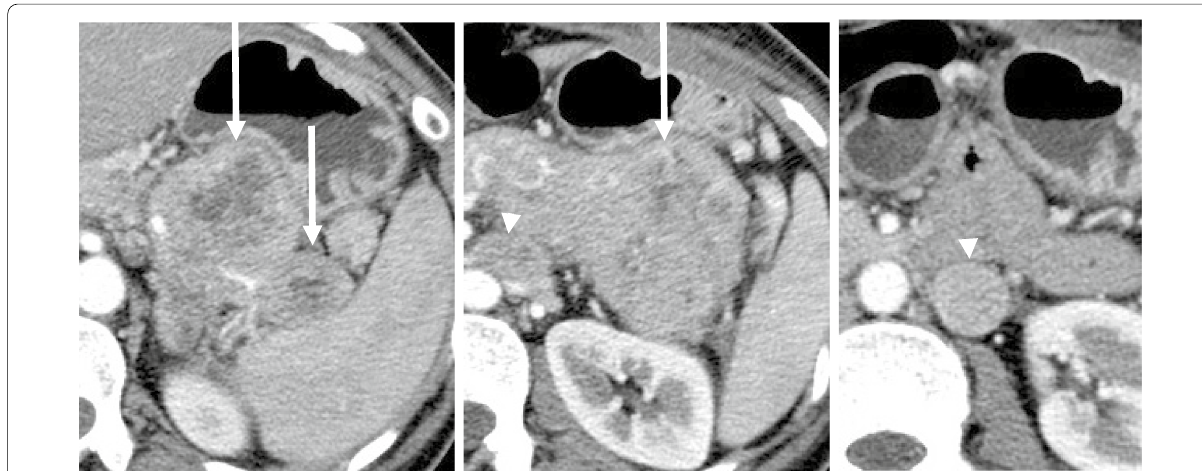
Fig. 1 Pancreatic metastases and paraaortic lymph node metastases. Late arterial phase of dynamic contrast-enhanced computed tomography showing heterogeneously enhanced multiple solid mass lesions with necrotic foci in the pancreatic tail and body up to 6.2 cm (arrow) with peripancreatic and paraaortic lymph nodes swelling (arrowhead)